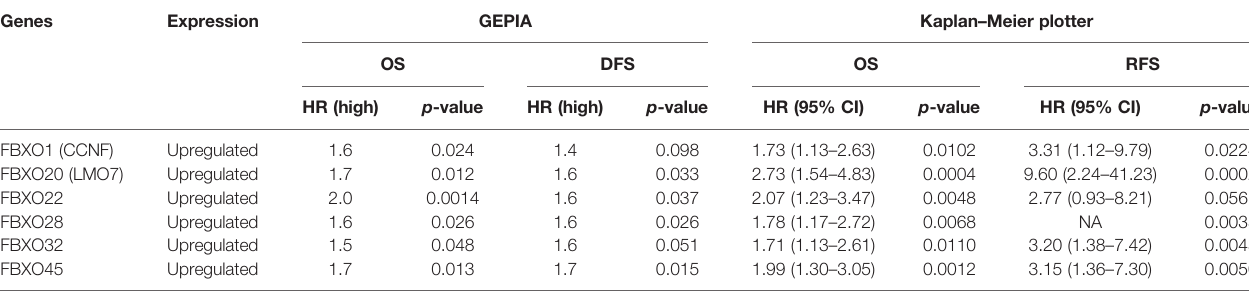
TABLE 2 | Prognostic analysis of the six-FBXOs in GEPIA and Kaplan – Meier plotter. Genes